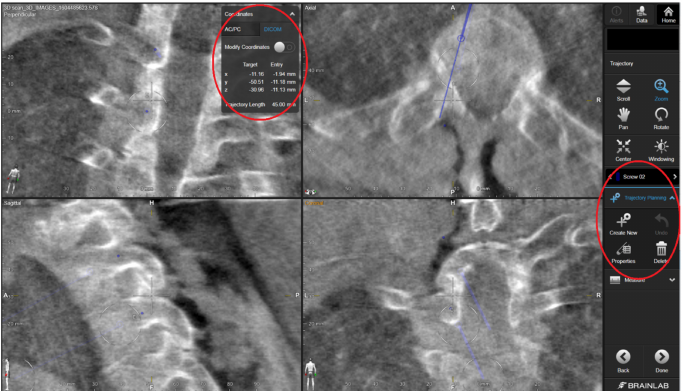
Figure 2. Retrieval of the DICOM coordinates of the intraoperatively stored trajectories accomplished by opening the spine planning file inside the cranial module of the planning